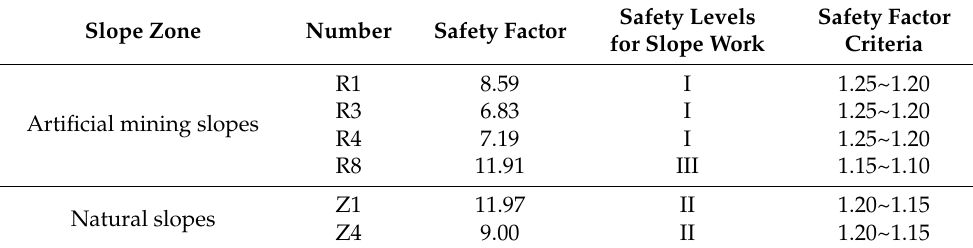
Table 6. Calculation results of the strength reduction method.